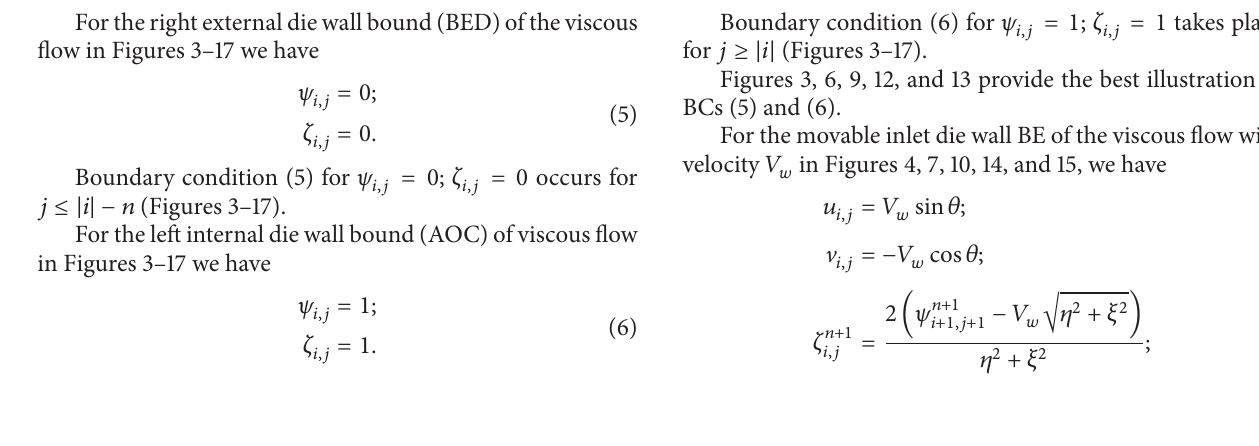
𝑉 = 2𝑈 𝑈 𝑤 0 (b, d), 0 is punching velocity, and the